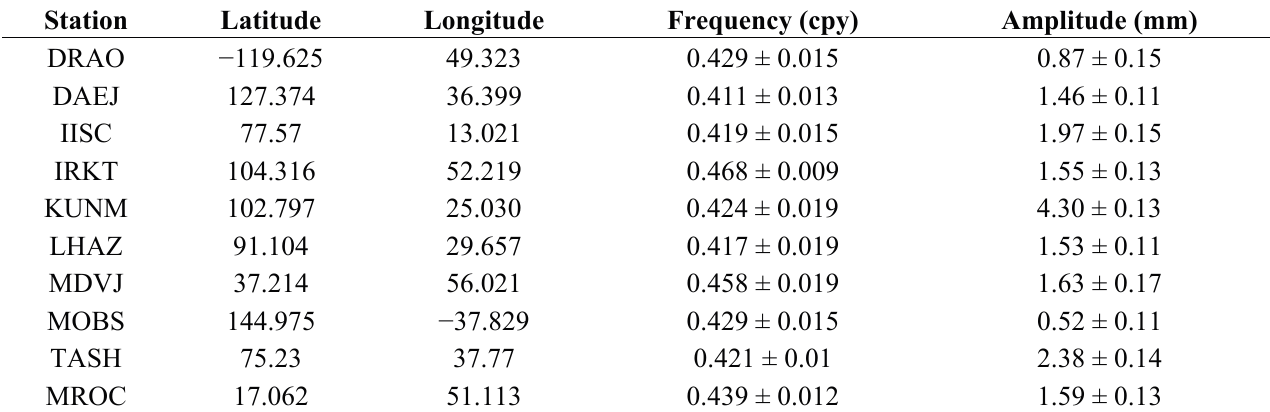
Table 1. The frequency and amplitude of quasi-biennial signal at selected GPS stations. Station